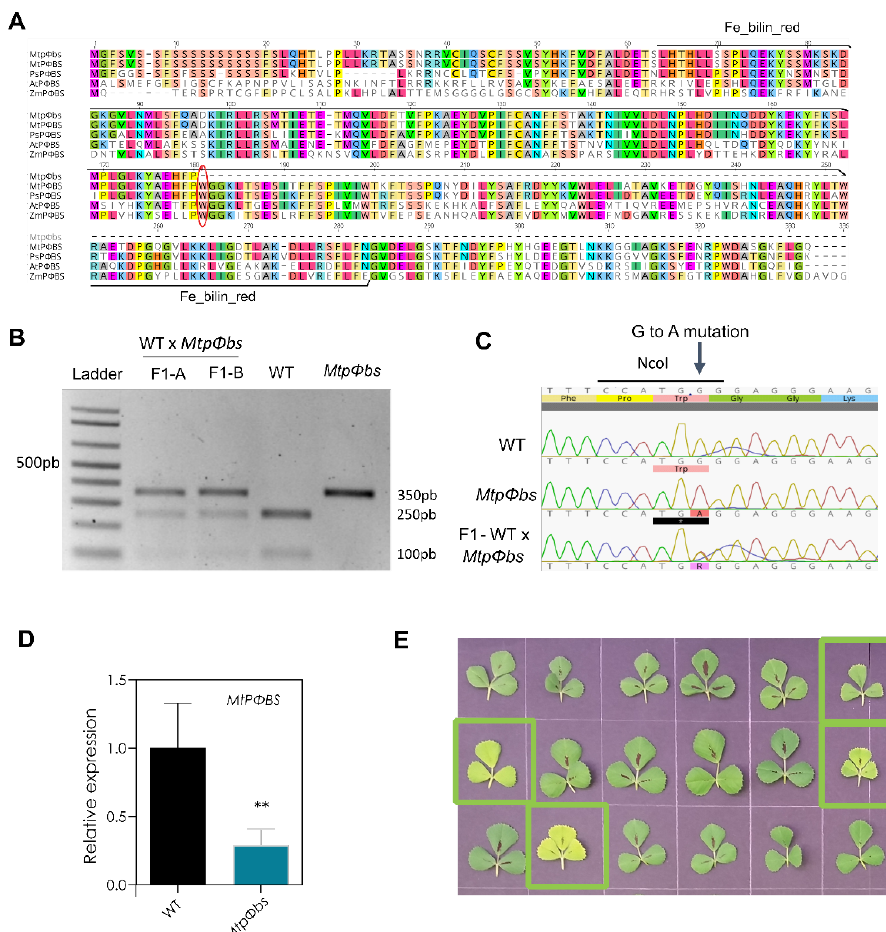
Figure 2. A point mutation in the MtP ϕ BS gene is responsible for the photo-morphogenic and late-flowering phenotypes. ( A ) Alignment of Medicago Medtr5g097080 ( MtP ϕ BS ) protein sequence with the P Φ BS sequence from other plant species showing the Ferredoxin-dependent bilin reductase (Fe_bilin_red) domain (from 63aa to 280aa). Red oval shows the location of the stop codon found in the Mtp ϕ bs mutant (178 aa Mtp ϕ bs vs. 329 aa WT). ( B ) The G > A mutation in Mtp ϕ bs causes a disruption of a NcoI restriction site. The NcoI restriction enzyme cuts PCR products from WT DNA (250 bp + 100 bp) but not Mtp ϕ bs DNA (350 bp). Heterozygous F1 plants A and B results in all 3 PCR products (350pb + 250 bp + 100 bp), confirming the WT × Mtp ϕ bs cross was successful. ( C ) Sequencing of the uncut products confirms the G > A change in the Mtp ϕ bs mutant and a double (A/G) peak in F1 plants. ( D ) MtP Φ BS expression levels were measured at ZT = 2 and primers were positioned upstream of the mutation site at the 5 (cid:48) end of the gene on either side of the exon1/exon2 boundary. Relative expression of WT-normalized to housekeeper MtPDF2 . ** p < 0.01 (Student t -test). Error bars represent SEM. ( E ) Picture of representative trifoliate leaves of F2-segregating population. Green squares indicate Mtp ϕ bs mutants confirmed using the NcoI PCR